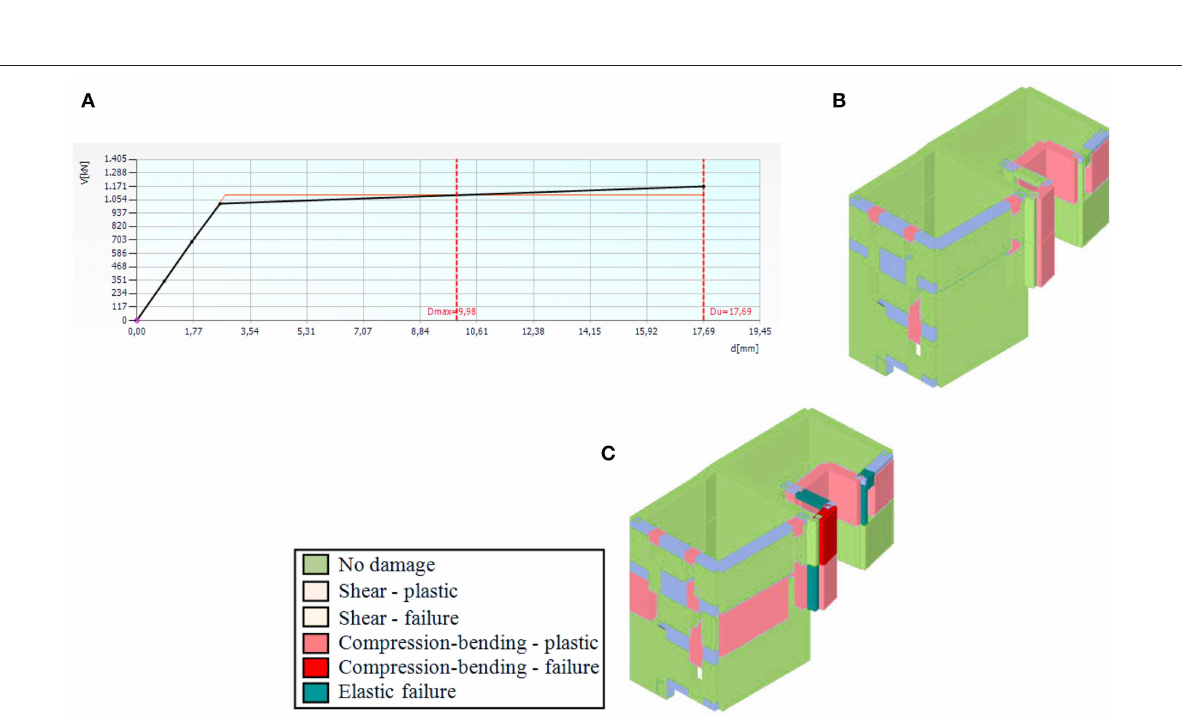
Frontiers in Built Environment |